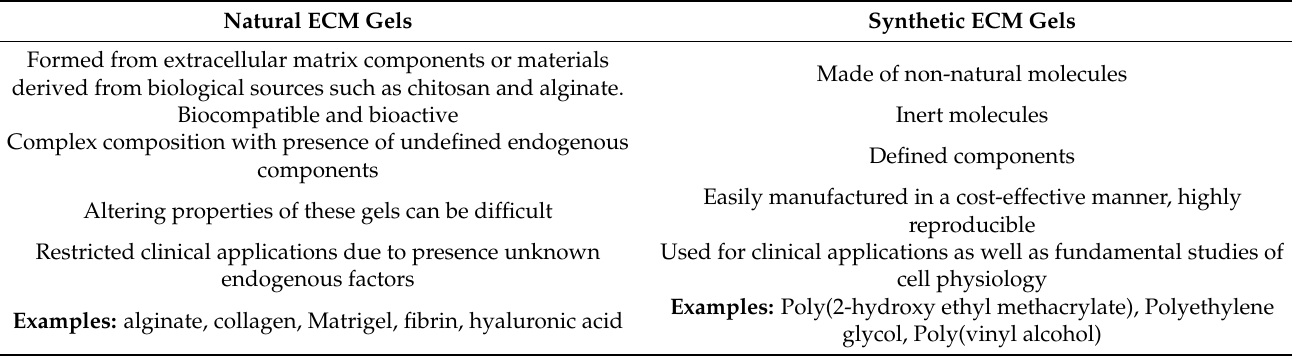
Table summarized from Tibbitt and Anseth (2009),